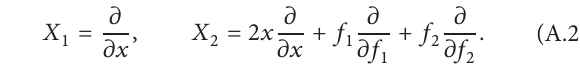
Table 2: Lie canonical forms of complex scalar equations. Type Complex symmetry